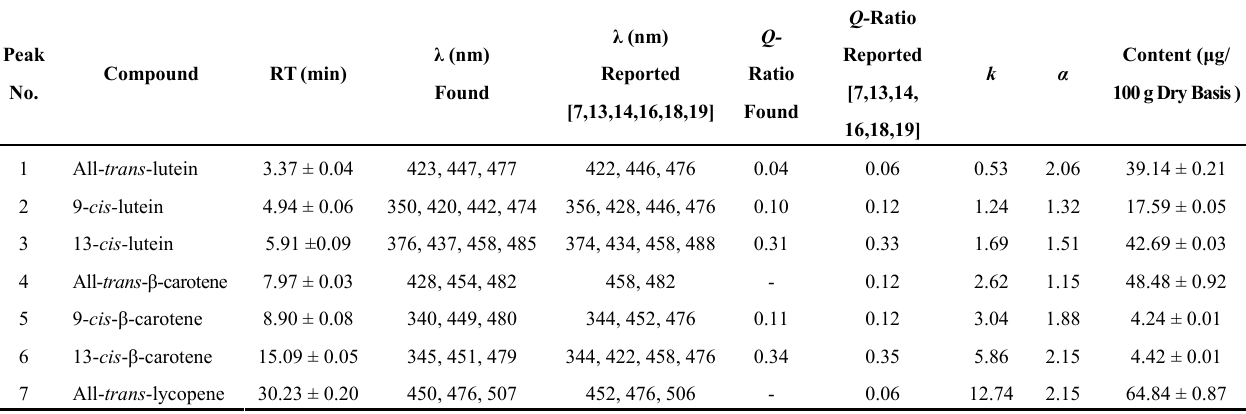
Table 1. Tentative identification, chromatographic data and content (μg/100 g dry basis) for all- trans and cis forms of carotenoids in tomato